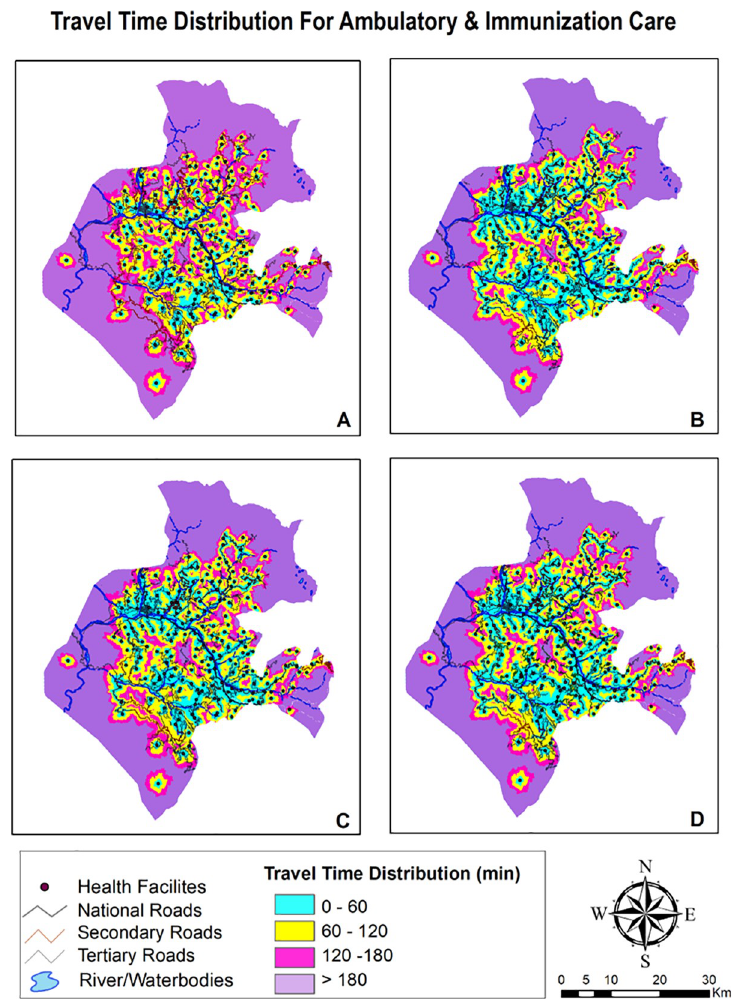
Fig 4. Mapping travel time grid for ambulatory & immunization